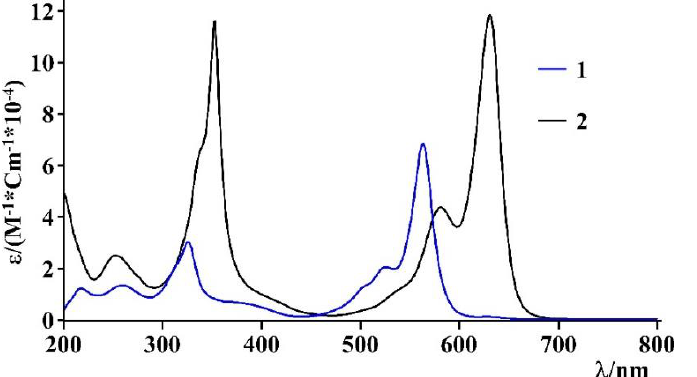
Figure 4. UV-vis absorption spectra of BODIPY 1 (blue line) and BODIPY 2 (black line) in acetonitrile. In particular, these systems show intense absorption bands, which are typical of BODIPY chromophore subunits, assigned at spin-allowed π - π * transitions, with a max- imum at 564 nm ( ε = 67,900 M − 1 cm − 1 ) for the BODIPY 1 and at 633 nm ( ε equal to 116,000 M − 1 cm − 1 ) for the BODIPY 2 . The main photophysical properties are reported in